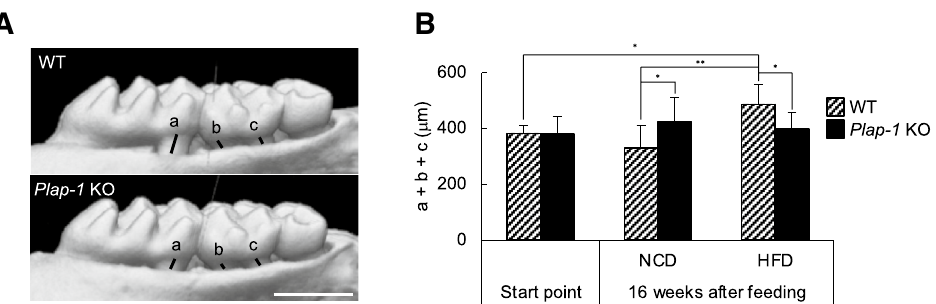
Figure 3. Evaluation of HFD-induced alveolar bone resorption. ( A ) Alveolar bone resorption was evaluated by μCT analysis in WT and Plap-1 KO mice fed with HFD. ( B ) Distance between alveolar bone crest and cement- enamel junction was measured at distal root of first molar (a), mesial (b) and distal (c) root of second molar. Start point/WT (n = 10), start point/ Plap-1 KO (n = 10), 16 weeks after feeding/NC/WT (n = 10), 16 weeks after feeding/NC/ Plap-1 KO (n = 8), 16 weeks after feeding/HFD/WT (n = 10), 16 weeks after feeding/HFD/ Plap-1 KO (n = 10). Results show the mean ± SD. *: p < 0.05, **: p < 0.01.